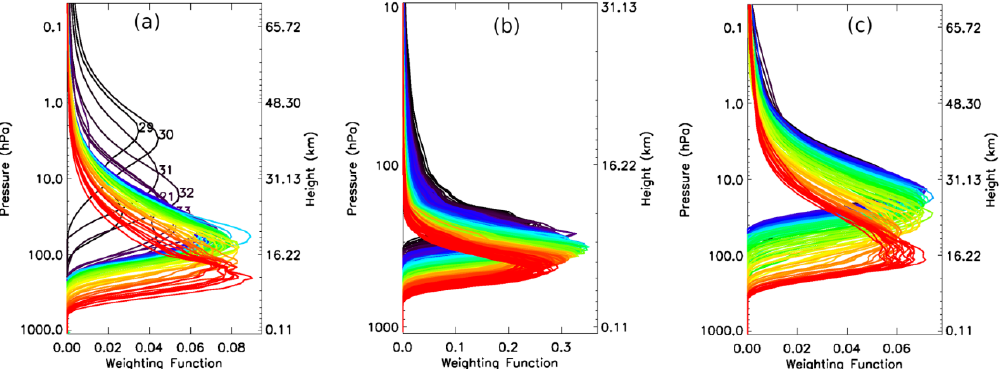
Figure 5. ( a ) Weighting function for LWIR CO 2 temperature sounding channels (1 to 81) 650 – 700 cm −1 (with cloud sensitivity height above ~6.8 km); ( b ) weighting function for MWIR water vapor channels (1155 to 1578) 1485.625 – 1750 cm −1 (with cloud sensitivity height above ~5 km); and ( c ) weighting function for SWIR CO 2 temperature sounding channels (1800 to 1931) 2293.125 – 2375.0 cm −1 (with cloud sensitivity height above 11 km).